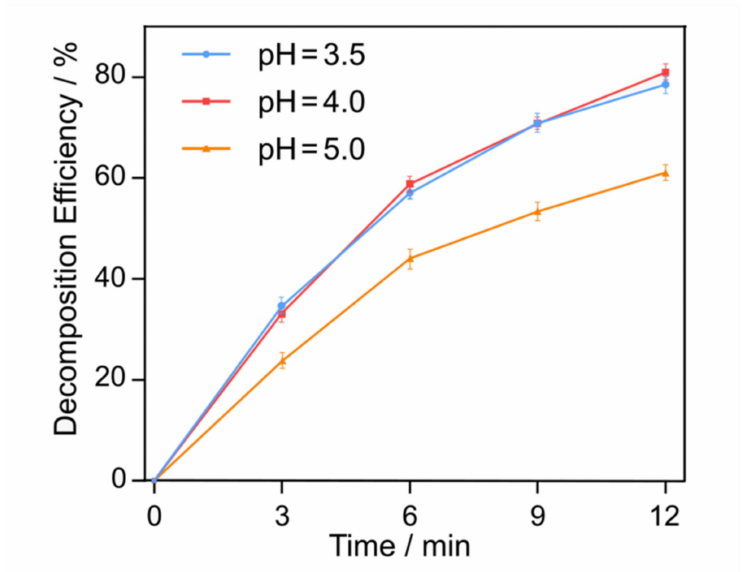
Figure 3. Time variation of RhB decomposition efficiency at various pH